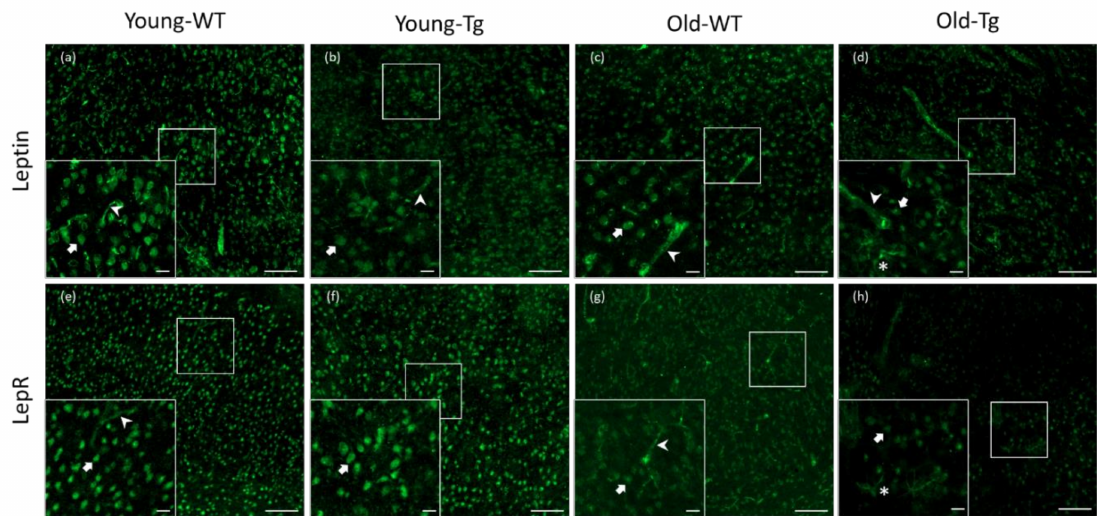
Figure 1. Expression of leptin and leptin receptor (LepR) in cerebral cortex of young (10–12 week) and old (48–52 week) wild-type (WT) and 5XFAD (Tg) mice. Leptin was detected in neurons and endothelial cells in ( a ) young-WT, ( b ) young-Tg and ( c ) old-WT mice. Leptin was detected in neurons and glia in ( d ) old-Tg mice. LepR expression was also detected in neurons and endothelial cells of ( e ) young-WT, ( f ) young-Tg and ( g ) old-WT mice. Moreover, LepR was observed to be expressed by neurons as well glia in ( h ) old-Tg mice. Block arrows—neurons; pointed arrows—endothelial cells; *—glia. Scale bar for large figures, 100 µ m; smaller figures in bottom left, 20 µ